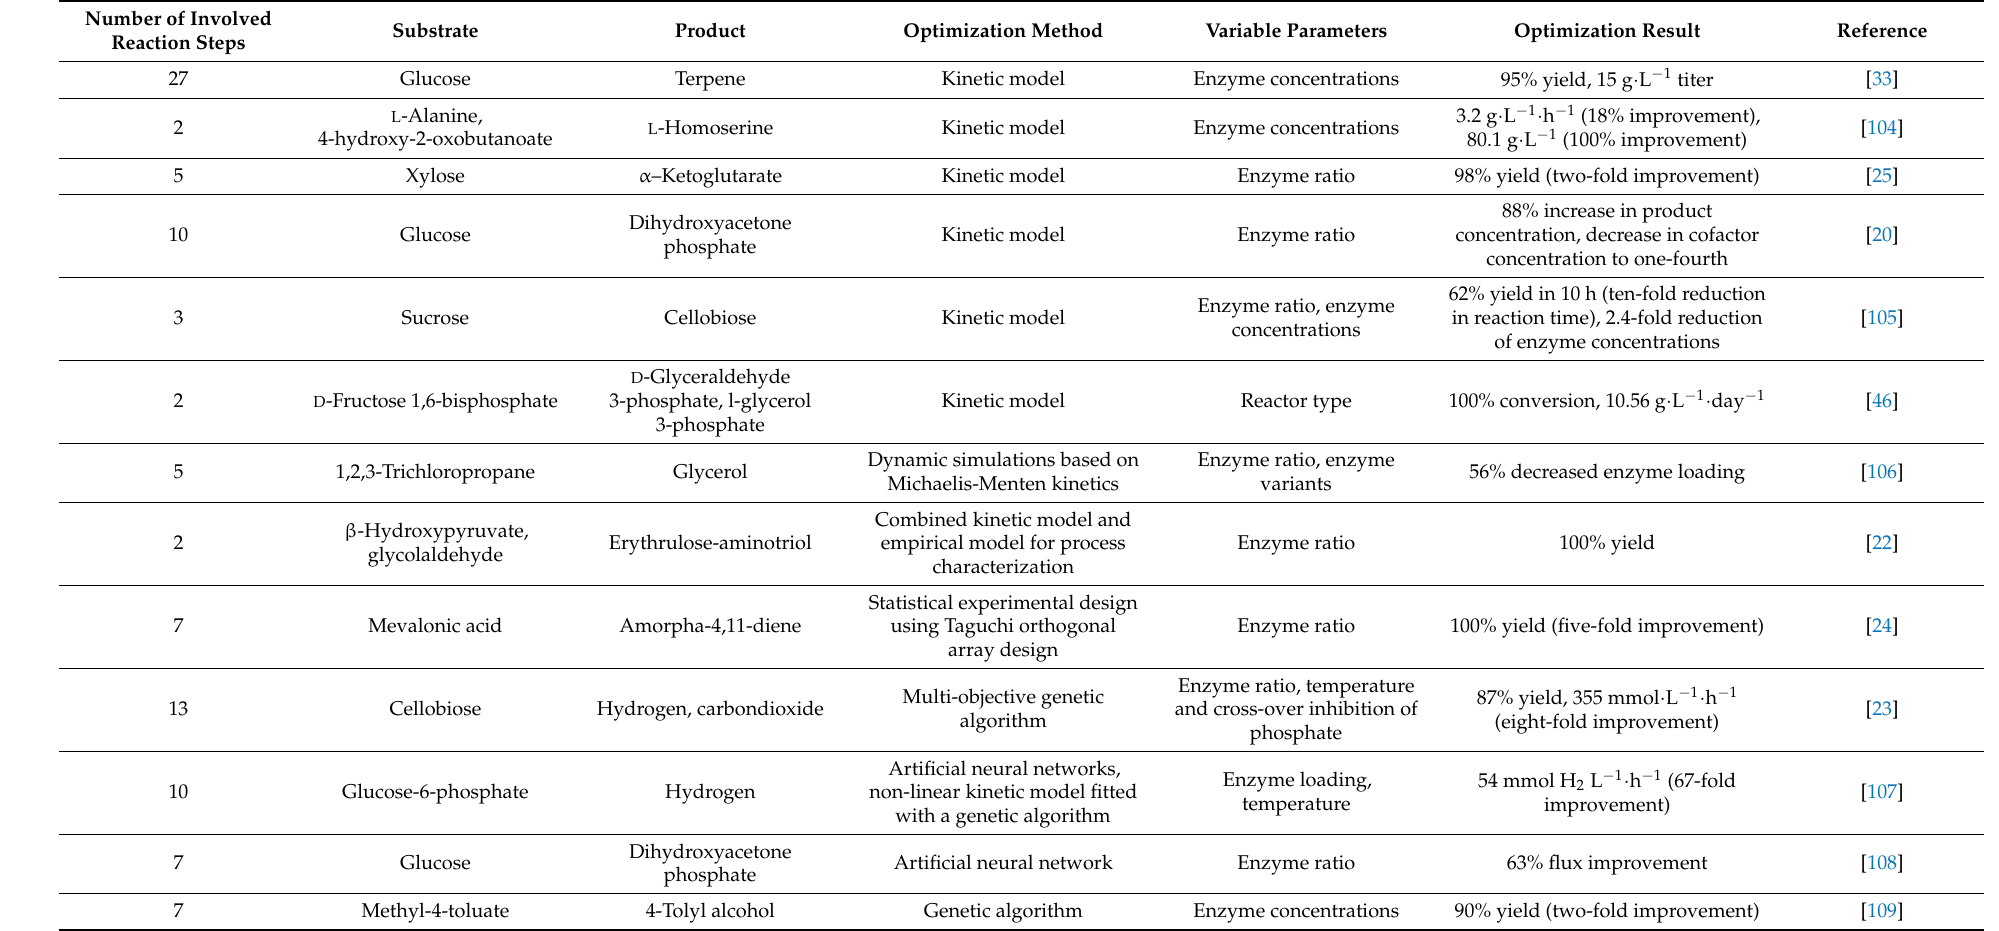
Table 2. Model based approaches for enzyme cascade